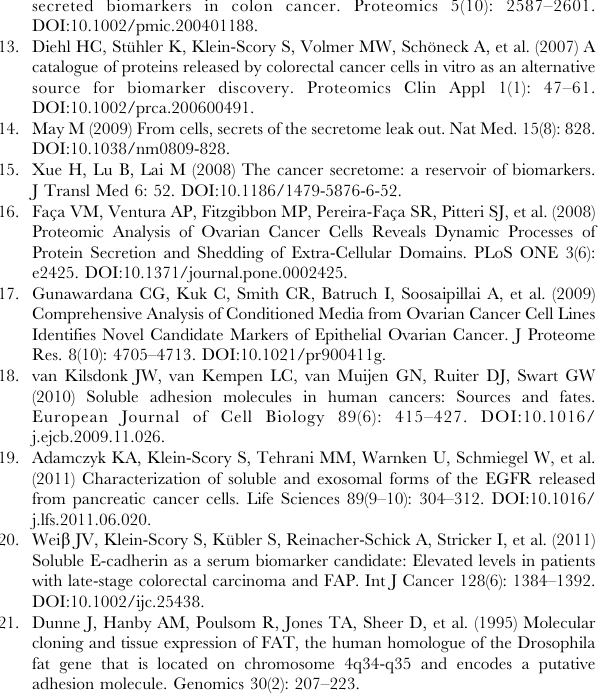
cultured in reduced serum media (Opti-MEM) collected one to five days prior to transfection (300 m l/well) were analyzed with the ELISA. (D) Day2 conditioned medium was diluted with PBS and applied to the ELISA as described for (C) using capture with the NTD7 mAb or the CTD7. Table S1 Agilent mRNA Expression profiles of all Fat proteins. The mRNA of the five pancreatic cancer cell lines A818, BxPc3, MiaPaCa2, Panc1 and PaCa44 and the control cell line HPDE were analyzed, using the Agilent software. A protein is expressed in the cell, when the normalized signal is . 5. Table S2 Agilent mRNA Expression profiles of all ADAMs. The mRNA of the five pancreatic cancer cell lines A818, BxPc3, MiaPaCa2, Panc1 and PaCa44 and the control cell line HPDE were analyzed, using the Agilent software. A protein is expressed in the cell, when the normalized signal is . 5. Table S3 MS-analyses of the high Mr band from enriched serum samples confirm the presence of Fat1. 2,5 ml serum from patients with pancreatic cancer or control subjects were subjected to the centrifugation protocol to enrich huge proteins as described in the materials and methods S1. 25 m g protein from the pancreatic cancer patient serum were separated using gel electrophoresis and the region corresponding to the Fat1- reactive band was cut out after krypton staining. The gel slices from both patient sera were found to contain Fat1-derived peptides. As a control the secretome from the PaCa44 cell line was analyzed in parallel and demonstrated good recovery of the Fat1 peptides.